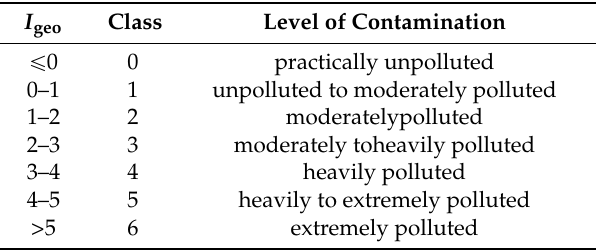
Table 2. Geo-accumulation index ( I geo ) and classes used for evaluation heavy metal (HM) contamination